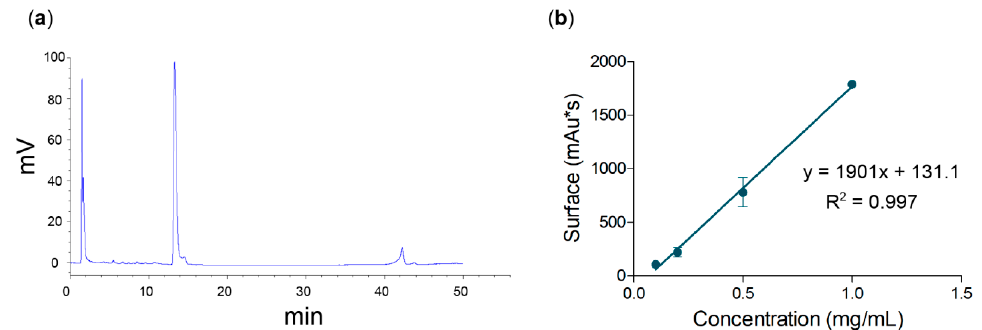
Figure 2. Quantitative analysis of nigericin determined by HPLC-evaporative light scattering detector (ELSD) analysis (RP-18, MeOH/H 2 O + 0.1% TFA gradient elution): ( a ) a representative chromatogram showing nigericin peak at 12.1 min, obtained by injecting the ethyl acetate extract from the SF10 strain cultured in solid state fermentation (SSF), D-glucose, pH 7, by incubation of 14 days at 30 °C; ( b ) calibration curve built using pure nigericin.